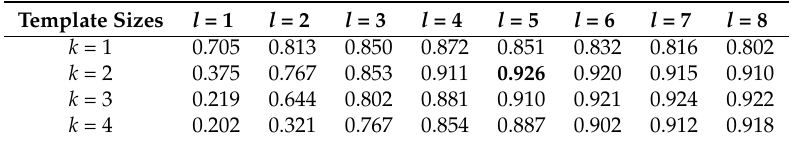
Table 1. Predictive performance of RPiRLS in terms of the AUC on the RPI2662 training set over varying template sizes.